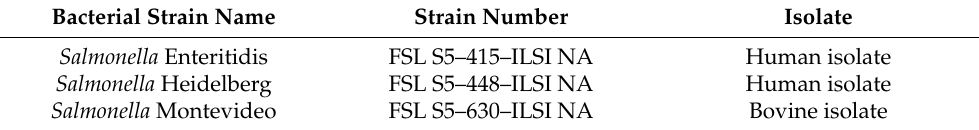
Table 1. Salmonella strains used in this research and their previous outbreak sources.